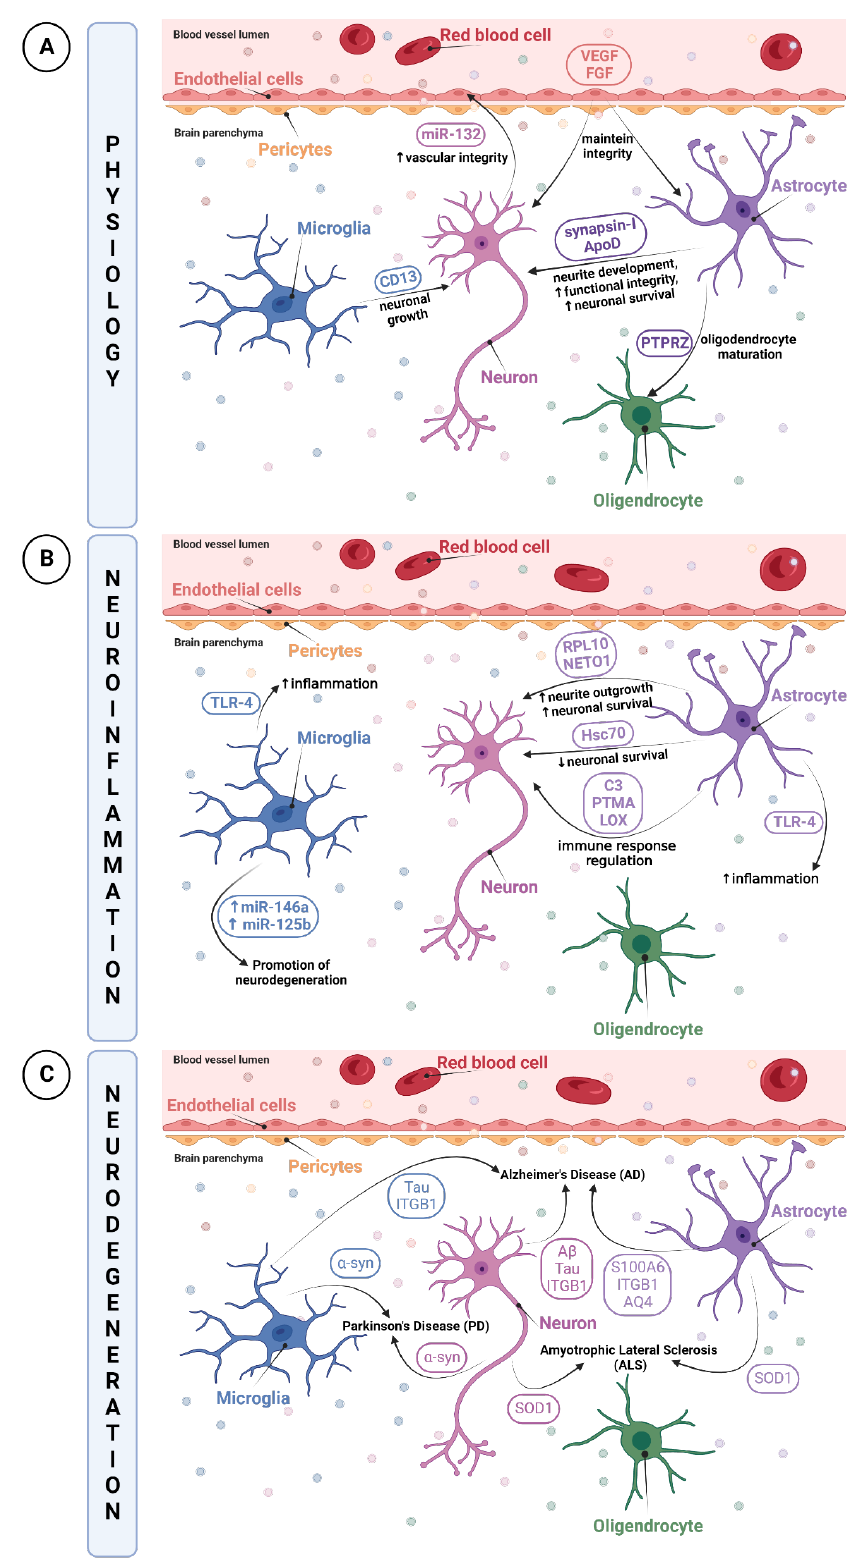
Figure 2. NVU-derived EV molecular content. Proteins and miRNAs contained in NVU-derived EVs are represented according to their role in ( A ) physiological conditions, ( B ) neuroinflammation, and ( C ) neurodegeneration. Proteins and miRNAs encircled in orange for endothelial cell-derived EVs, in blue for microglia-derived EVs, in pink for neuron-derived EVs, and in purple for astrocyte-derived EVs. Figure created with BioRender.com (accessed on the 26 August